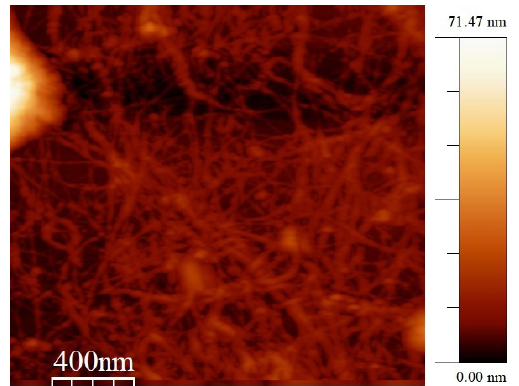
Figure 2. AFM images of the SWCNT analyzed sample.